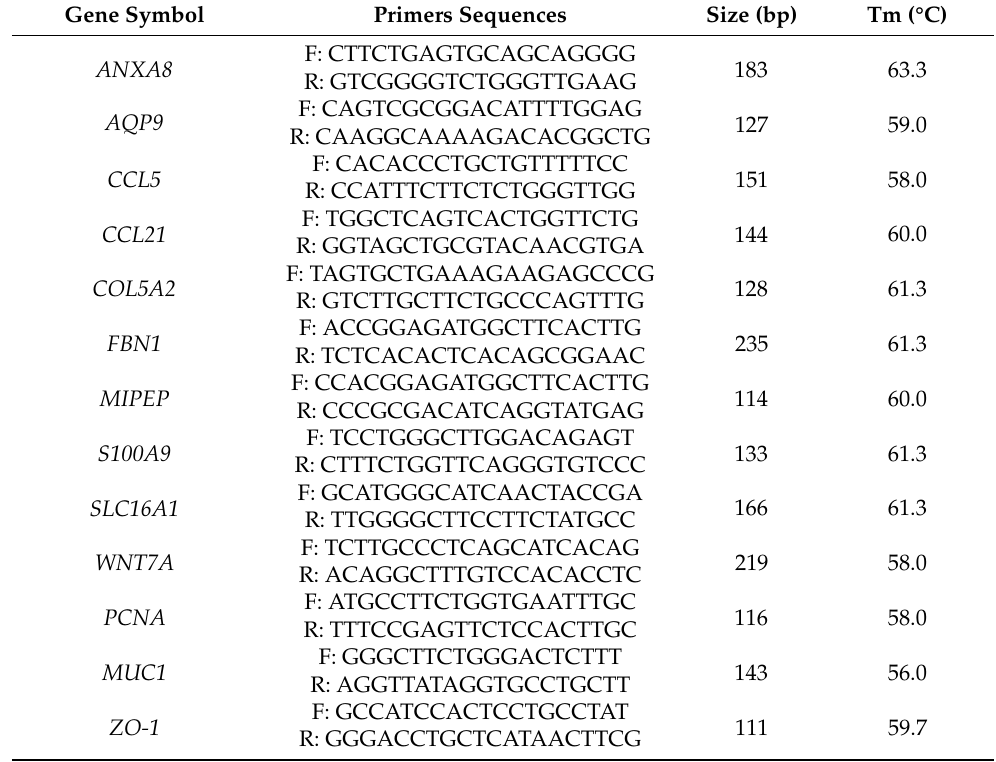
Table 2. Primers for